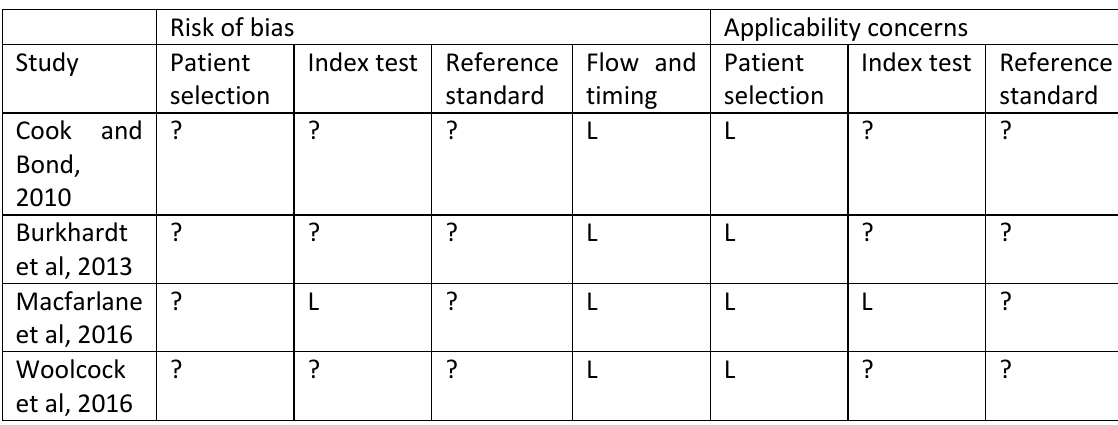
Table 1. Tabular presentation of the QUADAS-2 results for the studies included in this Knowledge Summary – H, high risk; L, low risk; ?, unclear risk (Whiting et al., 2011) Conclusion and implications for